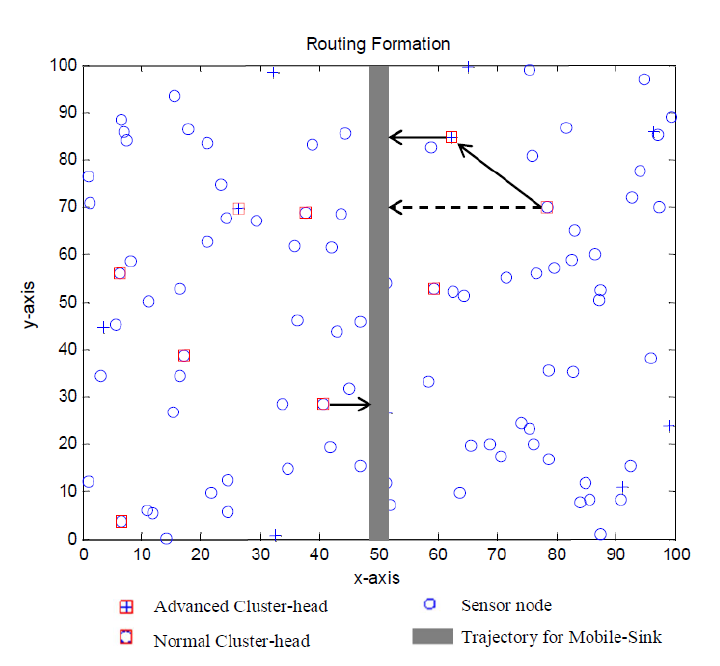
Figure 5. Routing strategy for